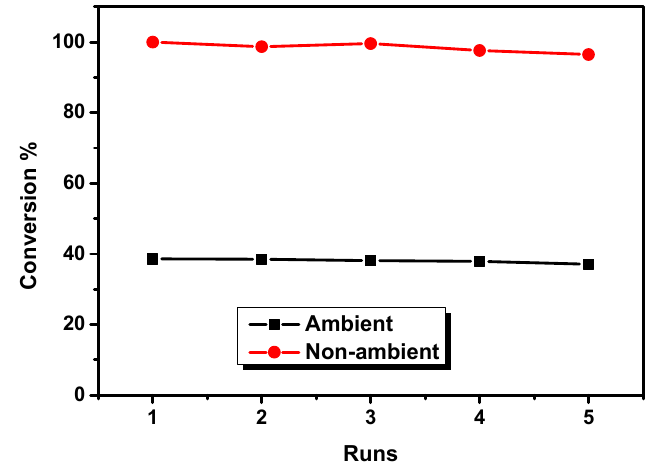
Figure 10. The activity of the Rh-2 sample in five consecutive runs of cyclohexene hydrogenation under ambient and non-ambient conditions.